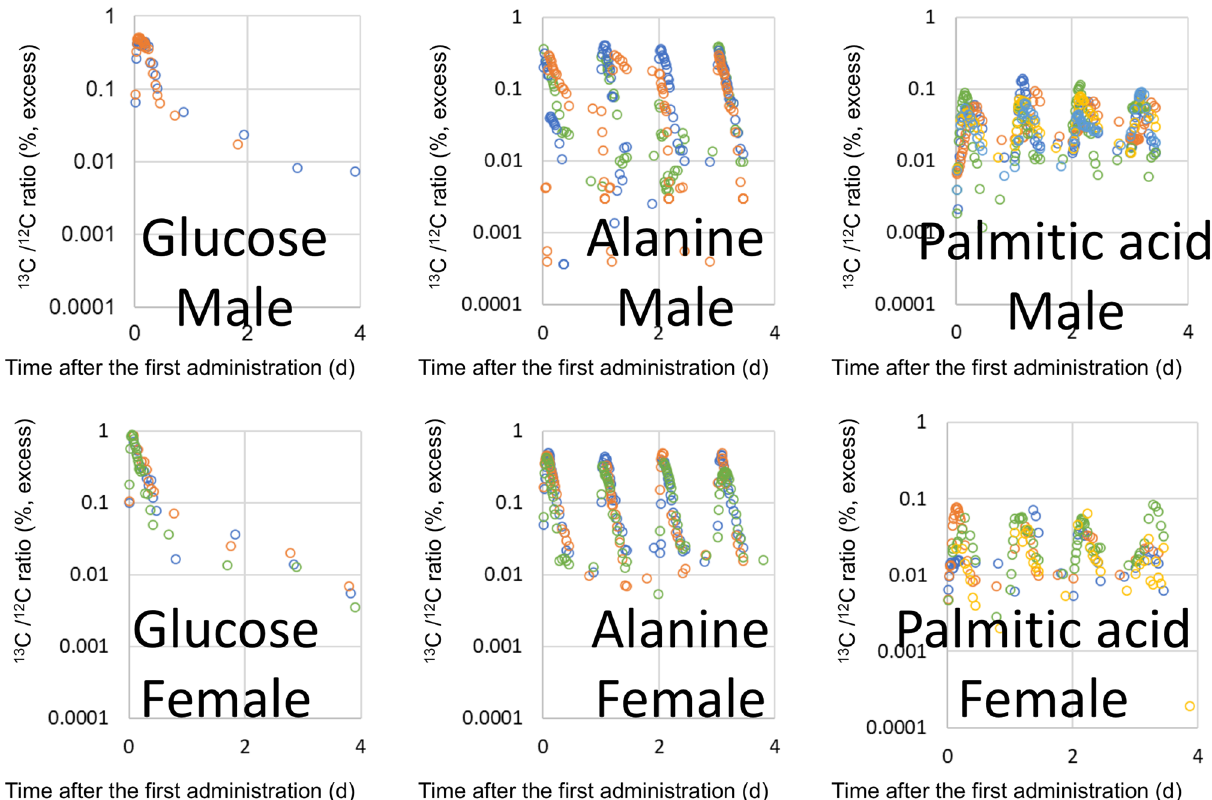
Figure 6. 13 C/ 12 C in breath after the oral administration of 13 C -labelled glucose, alanine, and palmitic acid. Each colour represents a different volunteer. 13 C -labelled alanine and palmitic acid were administered over four successive days. 13 C -labelled glucose soybean was administered once at day 0.